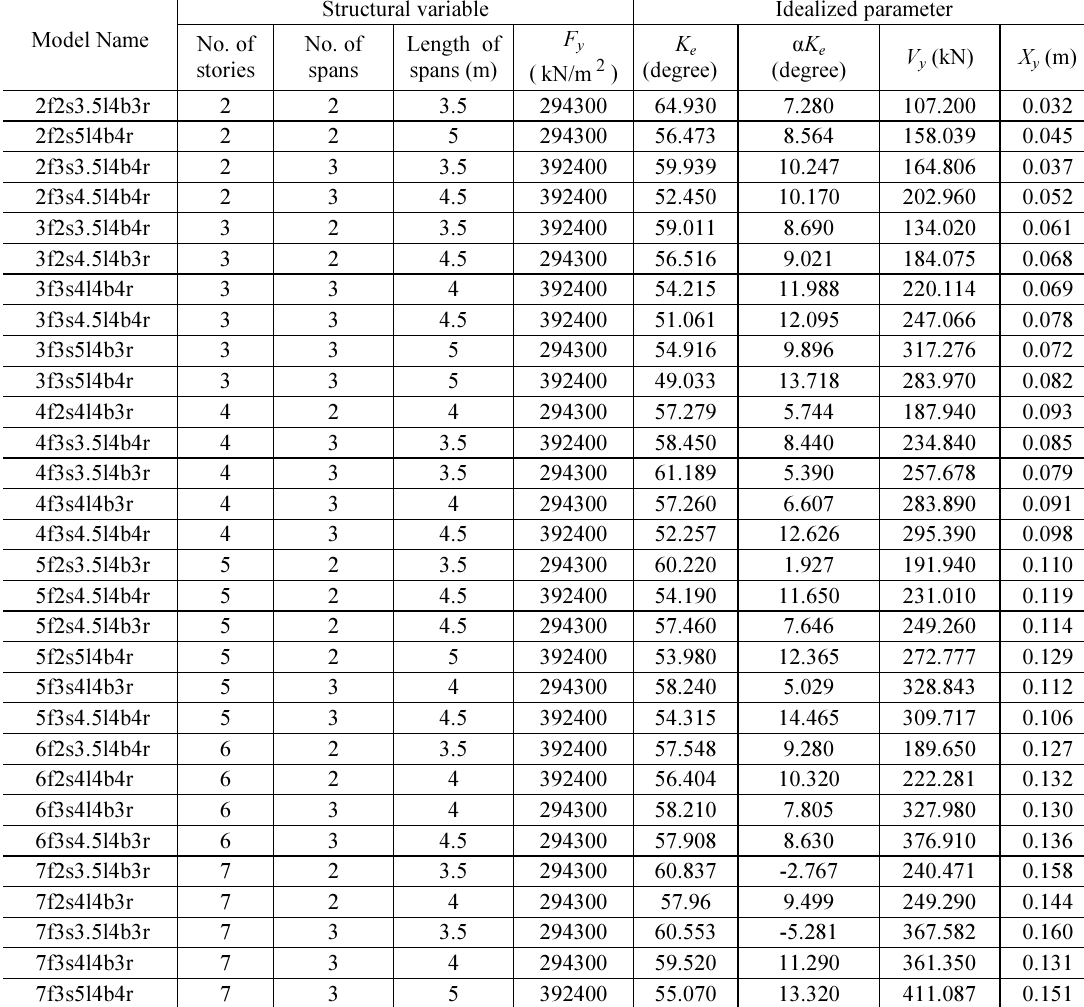
Table 6. Structural variable vs. corresponding extracted idealized parameters Structural variable Idealized parameter